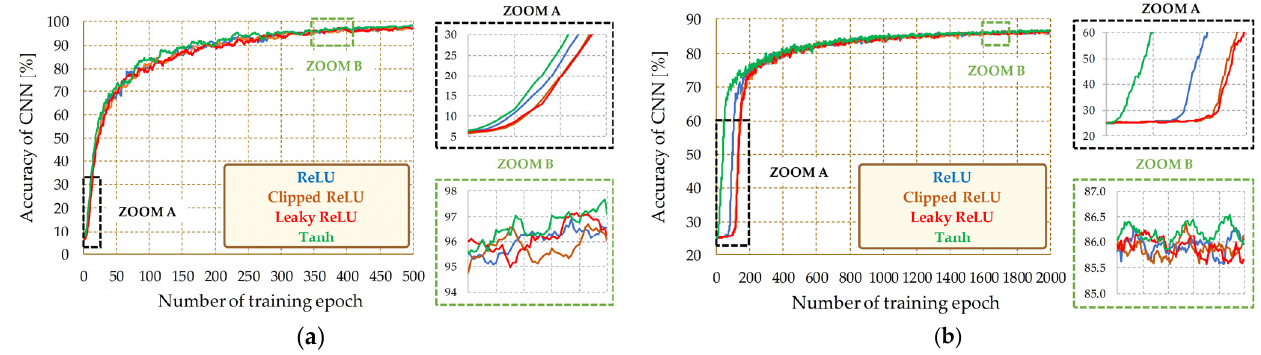
Figure 11. Influence of the CNN activation function on the precision of the diagnostic system— learning curves: ( a ) induction motor; ( b ) PMSM.